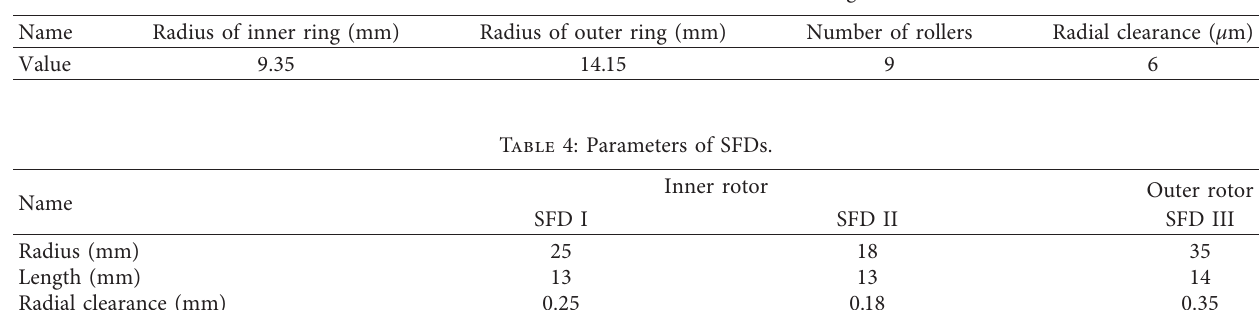
Table 3: Parameters of the intermediate bearing.